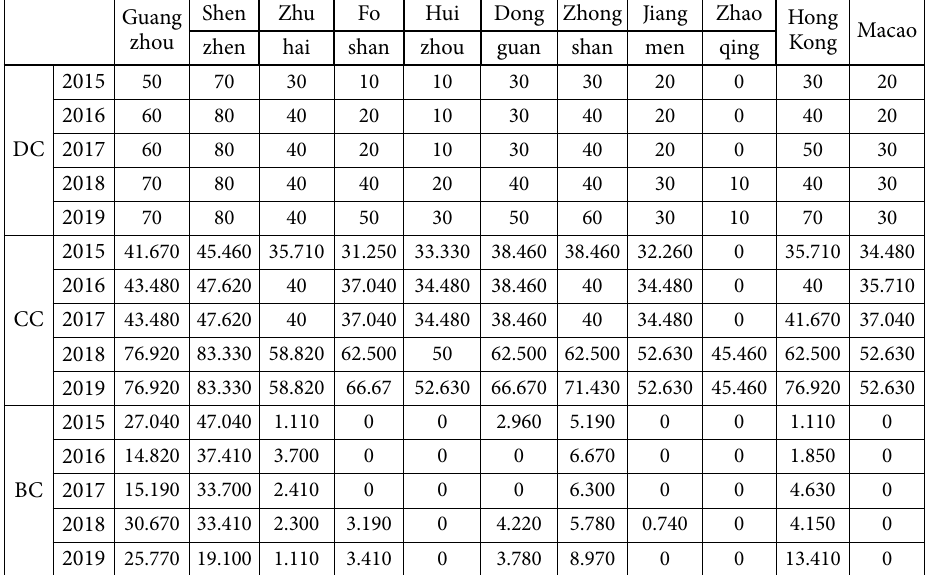
Table 5. Centrality of the GBA’s green development spatial association network Guang